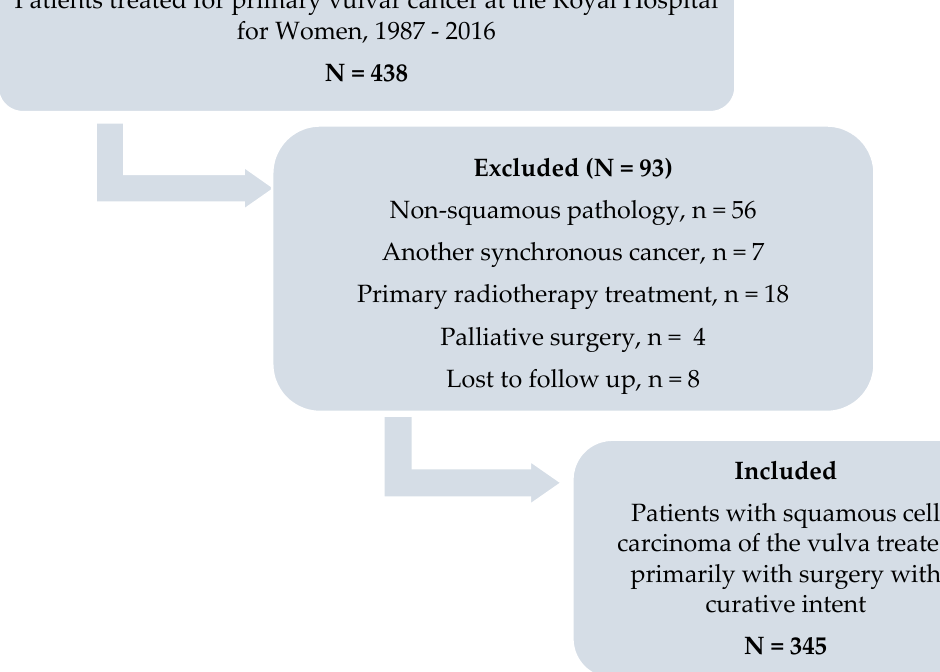
Figure 5. Flow diagram to illustrate patients included and excluded from the study.